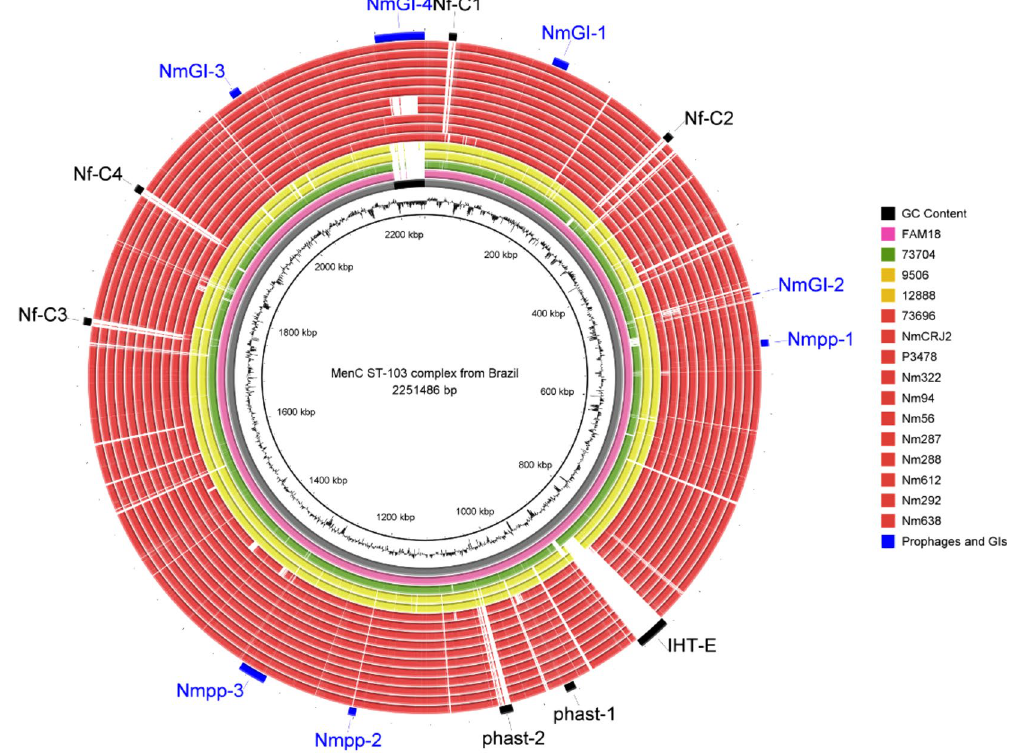
Figure 2. Circular representation of the genomes from N . meningitidis serogroup C (MenC) strains isolated from Brazil. The draft genomes were aligned against FAM18 reference genome. The inner circle (histogram) shows G + C content variations throughout the genome. The gray circle represents the compared chromosomal regions and the black region placed in the terminus region ( ∼ 2 ,200 bp) represents regions not allocated as part of the chromosomal genome. Each genome is represented by a colored circle. The red circles represent Brazilian MenC genomes from CC103 clonal complex harbouring the ICE Nm CC103. The variable regions such as prophages and genomic islands, including the NmGI-4 (ICE Nm CC103 element), are